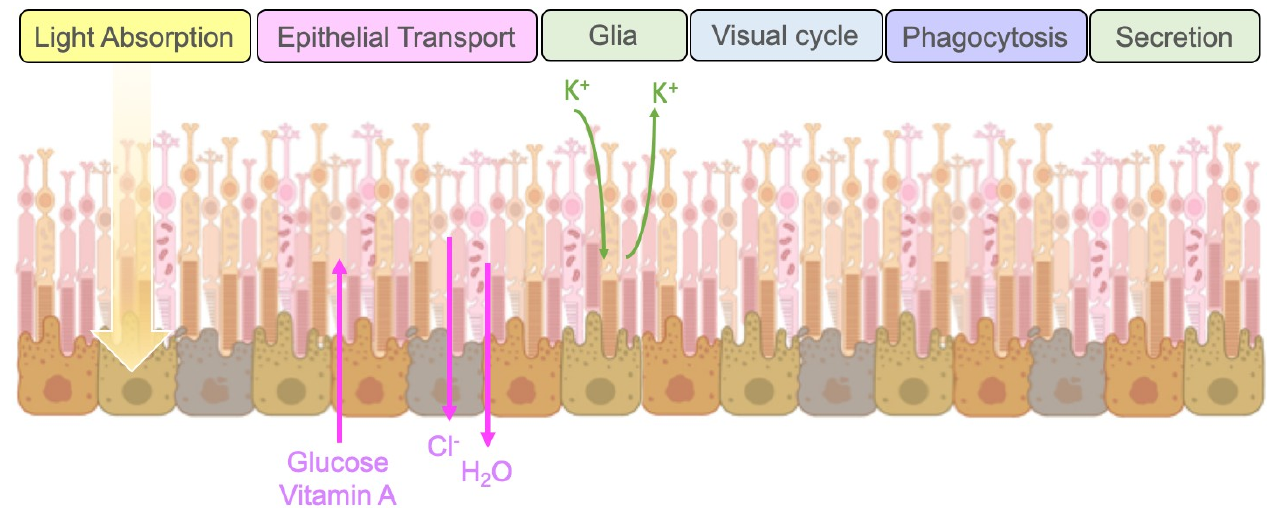
Figure 4. General physiological functions of RPEs. The general functions of RPEs include light ab- sorption, the trans-epithelial transport of molecules and ions, the spatial buffering of ions, regulation of the visual cycle, phagocytosis of shed photoreceptor membranes, and the secretion of growth factors. (Image credit—Created with BioRender.com)